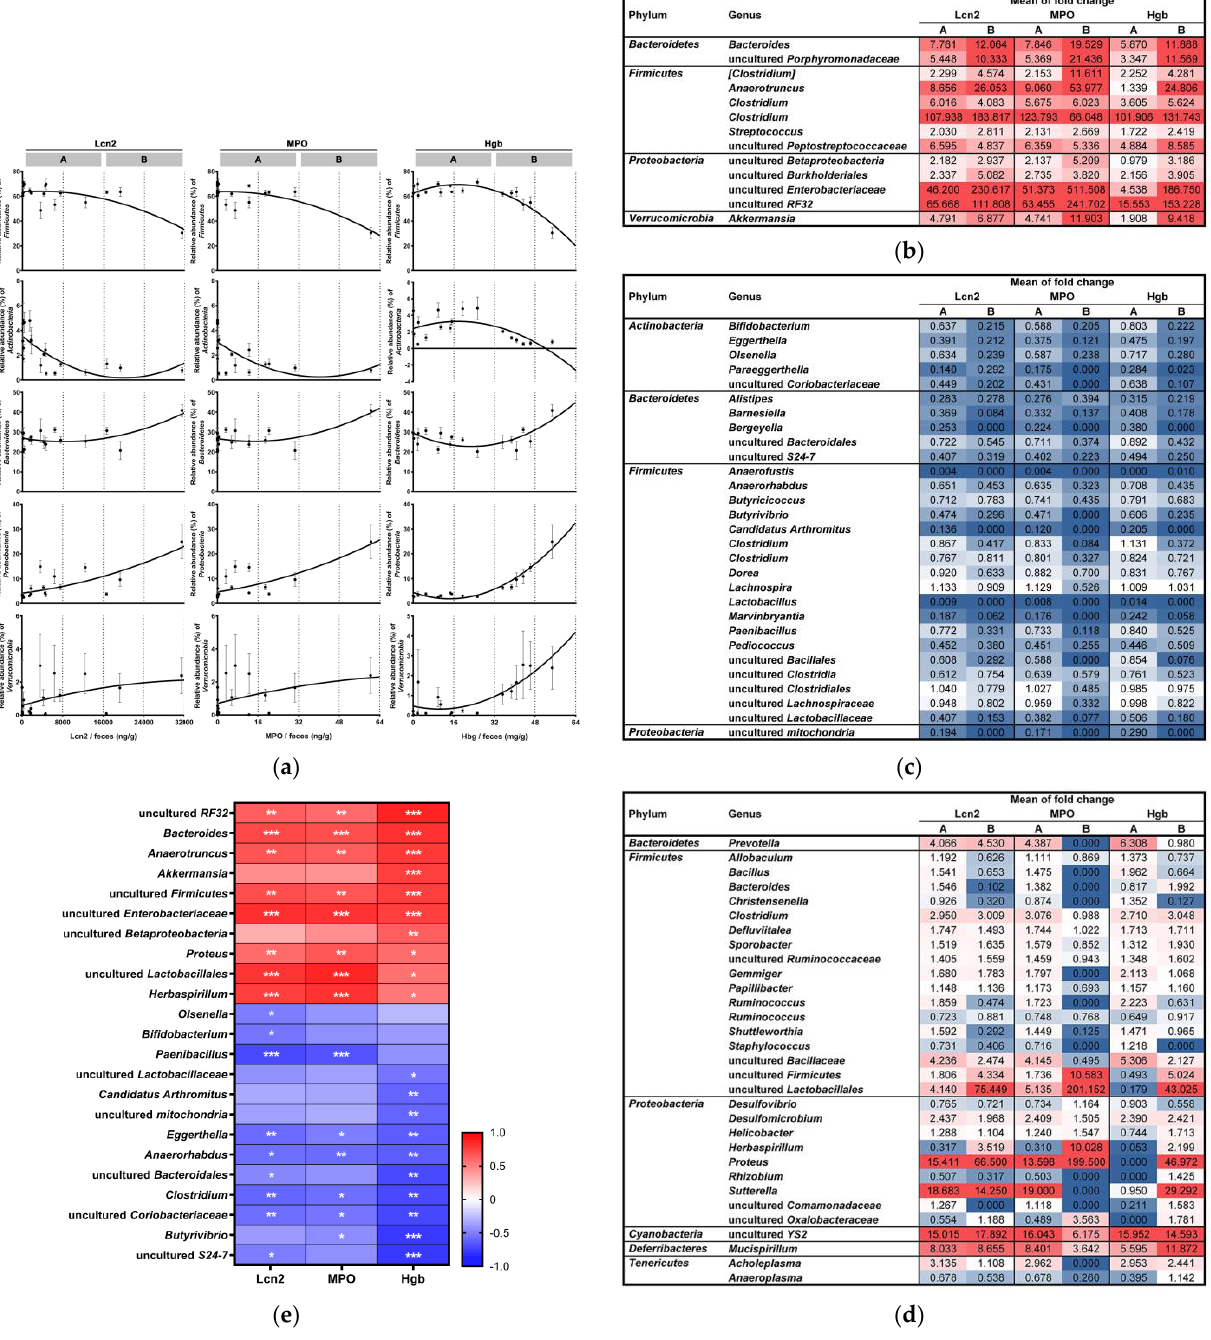
Figure 4. Dynamics of the gut microbiota based on microbial susceptibility to colitis severity. ( a ) Dynamics of microbial changes at the major phylum level. Constantly ( b ) increasing or ( c ) decreasing genus populations from mild to severe status, respectively. ( d ) Taxonomic groups showing dynamic fluctuations from mild to severe status. Color gradients indicate, as follows: compared to the negative control, blue represents decreased populations (fold change < 1.0), red represents increased populations (fold change > 1.0), and white shows no changes (fold change = 1.0). ( e ) Correlation between the resulting RAs and colitis indicators. Statistical significance is indicated as follows: * p < 0.05, ** p < 0.01, and *** p < 0.001.